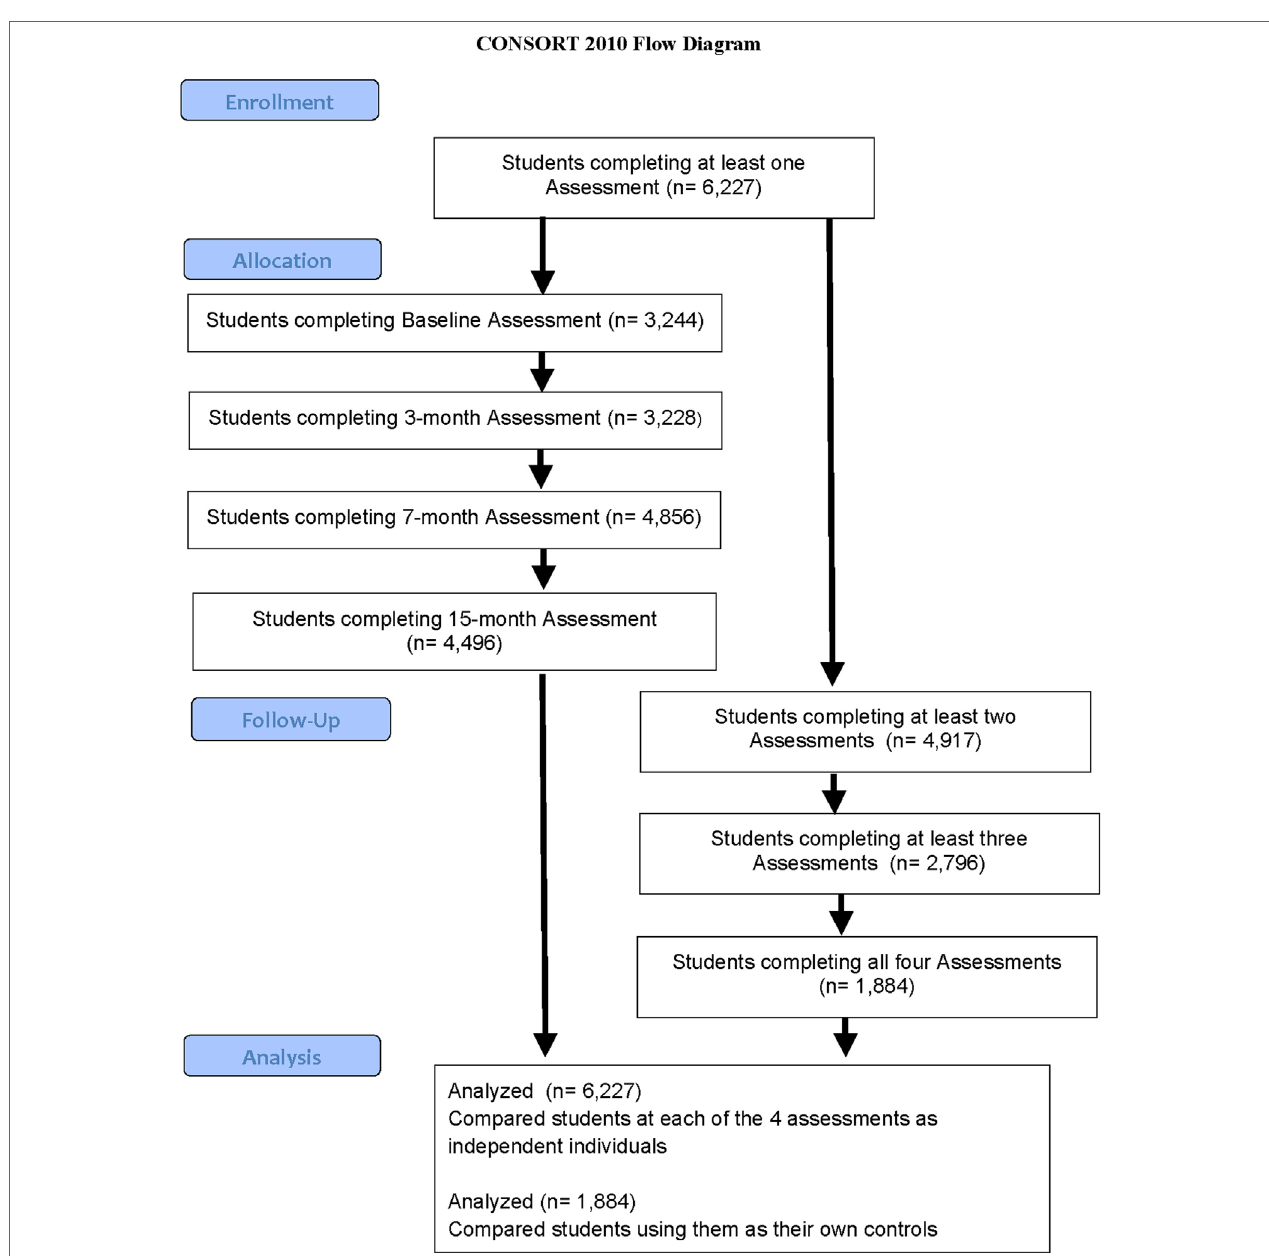
FigUre 2 | Flowchart demonstrating assessment completion by students . Shows how many students completed an assessment at baseline, 3, 7, and 15 months (on the left-hand side) as well as how many students completed multiple assessments (on the right-hand